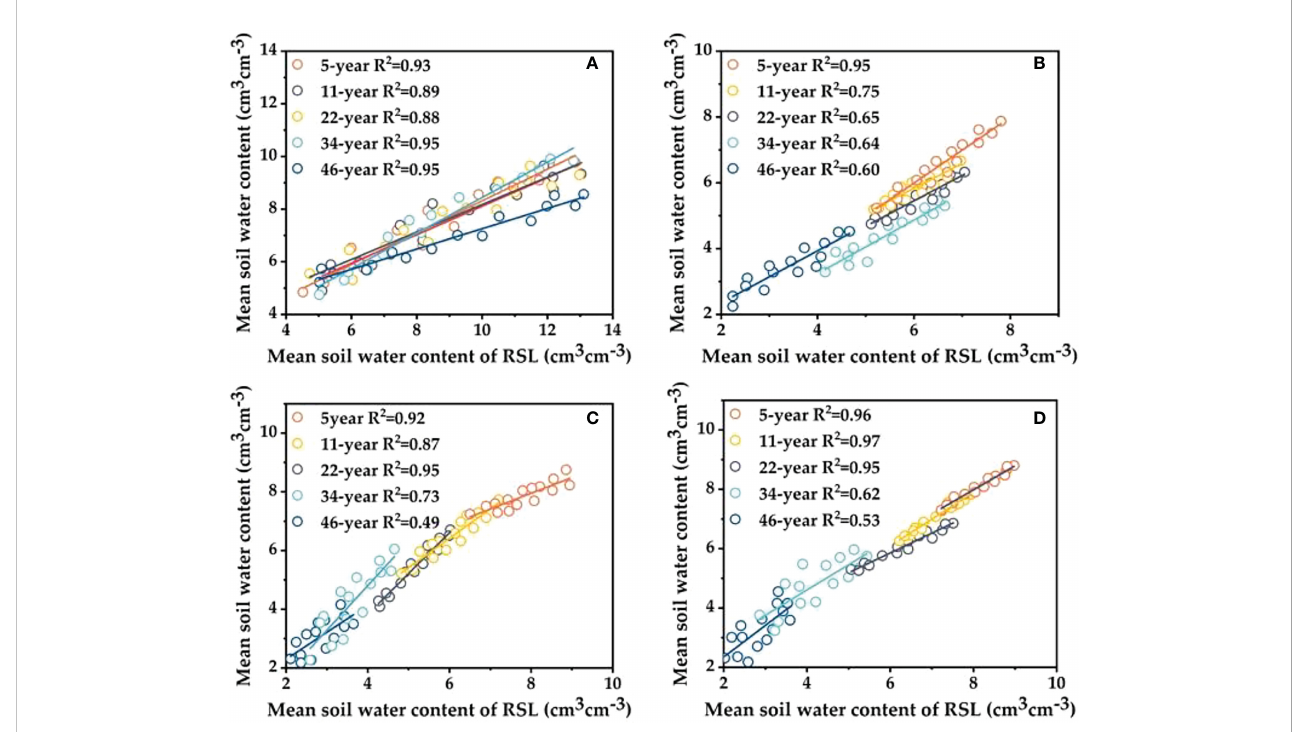
FIGURE 6 Comparisons of measured SWC at the most time-stable location with the estimated values in the four soil layers under fi ve different stand ages: (A) 0 — 100 cm, (B) 100 — 200 cm, (C) 200 — 300 cm, (D) 300 — 400